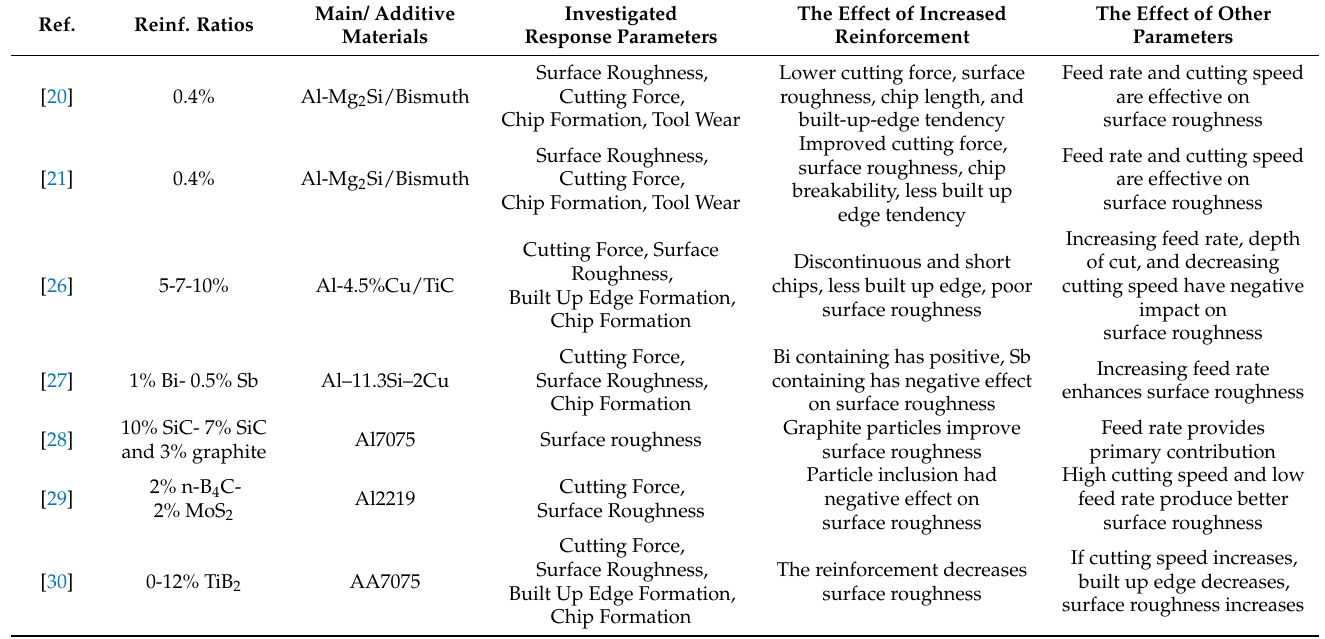
Table 1. A literature summary of the turning of the particle reinforced composites.